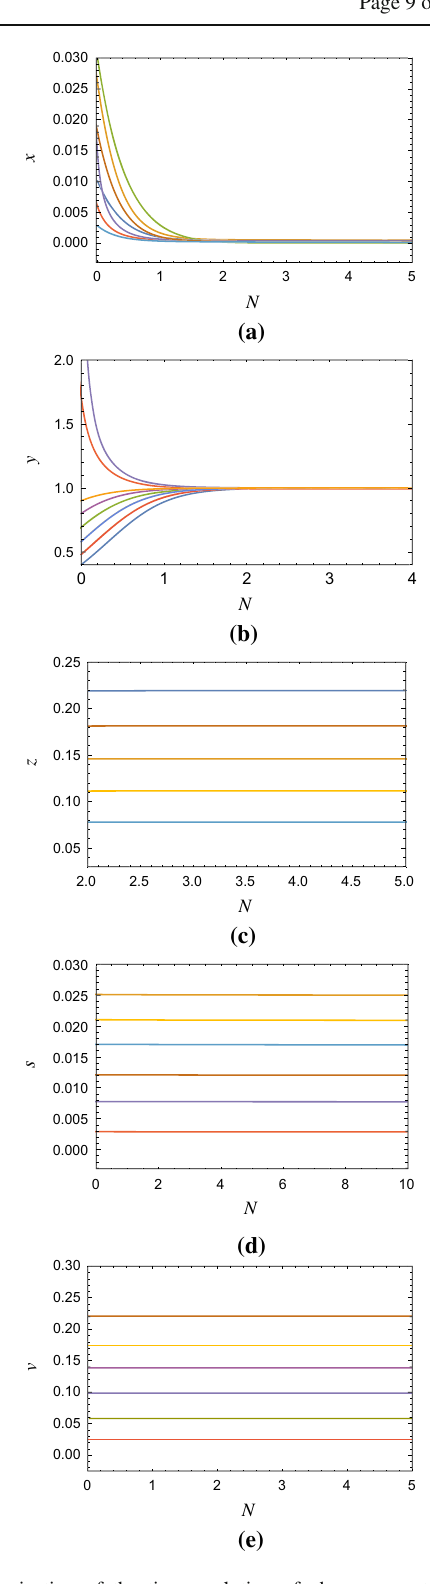
Fig. 4 Projection of the time evolution of phase space trajectories along the a x -axis, b y -axis, c z -axis, d s -axis and e v -axis which determine the stability of set D 2 . Here, we take w = 0, α = 0 .